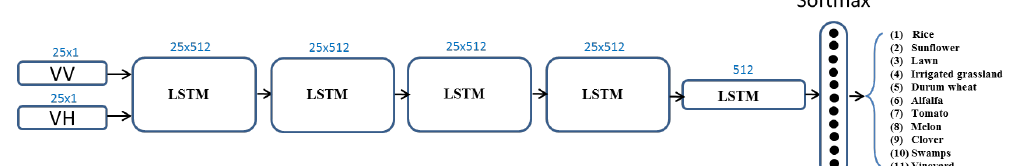
Figure 5. The schematic view of the RNN LSTM -based architecture. By replacing LSTM to GRU unit, we get the RNN GRU -based